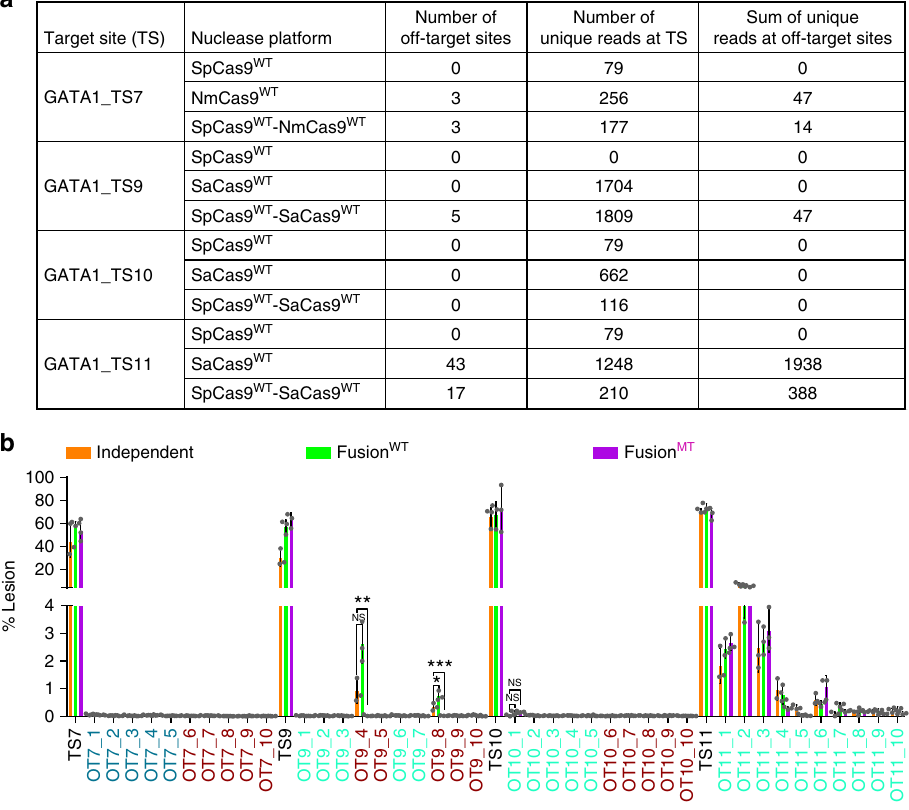
Fig. 6 Cas9 – Cas9 fusions achieve robust and speci fi c genome editing. a Summary of the GUIDE-seq genome-wide off-target analysis of SpCas9 WT , Sa/ NmCas9 WT , and SpCas9 WT -Sa/NmCas9 WT at four GATA1 target sites (Supplementary Data 2). b Deep sequencing determined lesion rates for these nucleases at a subset of off-target sites discovered by the GUIDE-seq data or predicted by CasOFFinder (Supplementary Data 3). The names of SpCas9, NmCas9, and SaCas9 off-target sites are colored in dark red, blue, and green. The GUIDE-seq result is from single experiment, and amplicon deep sequencing data are from three independent biological replicates performed on different days in HEK293T cells (Supplementary Data 1). Error bars indicate ± s.e.m. Statistical signi fi cance is determined by one-way analysis of variance (ANOVA), *, **, ***, and NS denote BH-adjusted P -values of <0.05, <0.01, <0.001, and not signi fi cant,